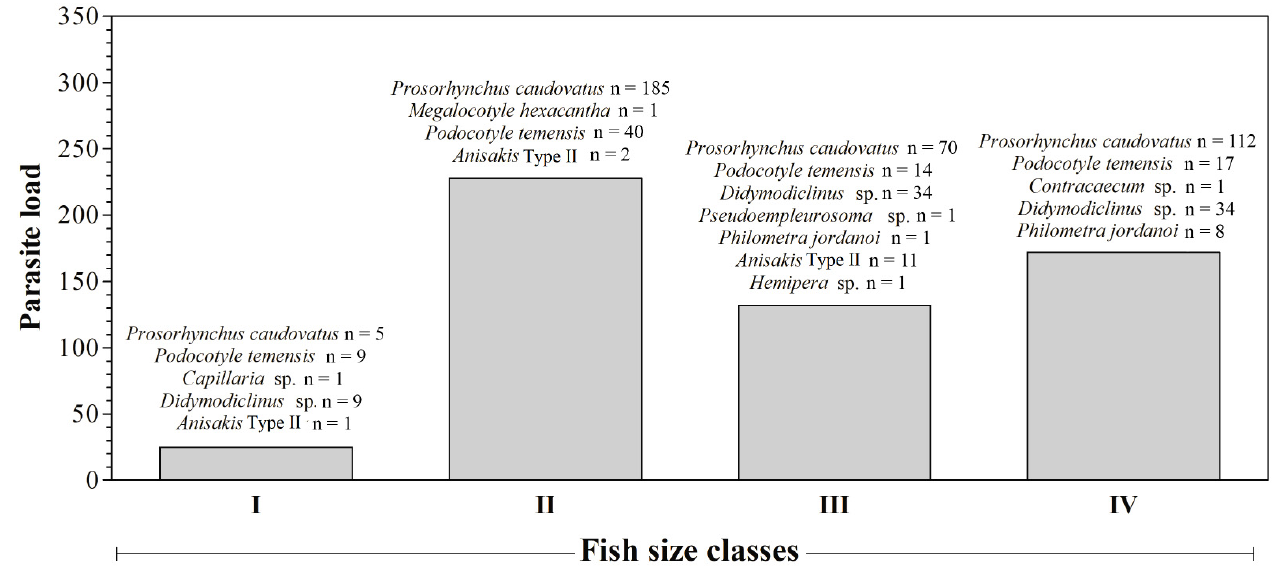
Figure 2. Number of parasites per species according to different size classes. Gross lesions in the coelomatic organs of E. marginatus specimens attributable to parasite infection were not observed, and macroscopic gonadal alterations resulting from the presence of P. jordanoi (one to five specimens per fish) or gill damage caused by Didymodiclinus sp. were not found.